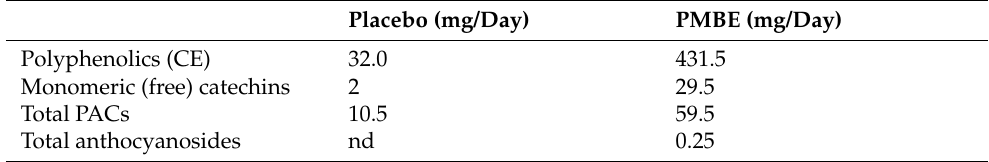
Table 1. Composition of study products 1